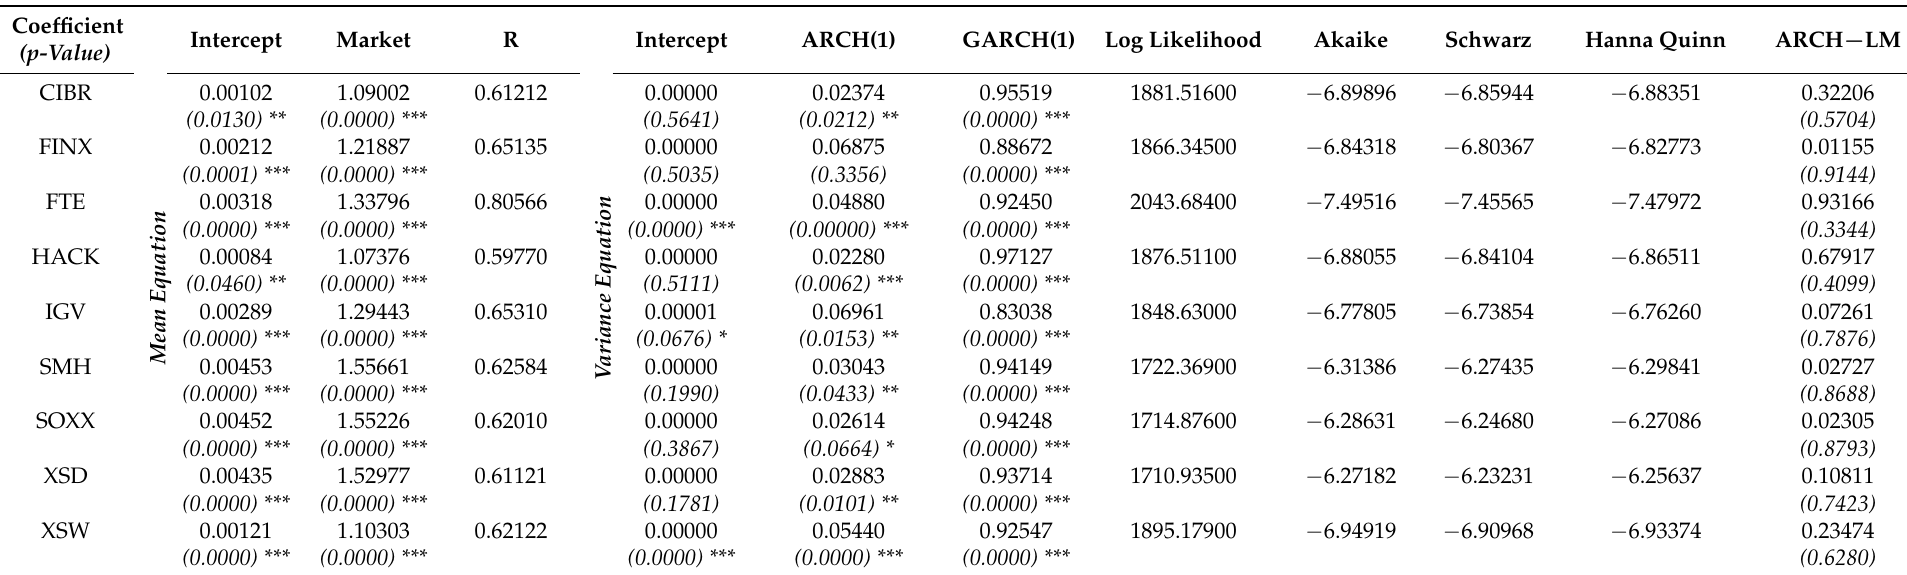
Table A4. Generalized autoregressive conditional heteroskedastic (GARCH) (1,1) one-factor model for constructing the idiosyncratic volatility